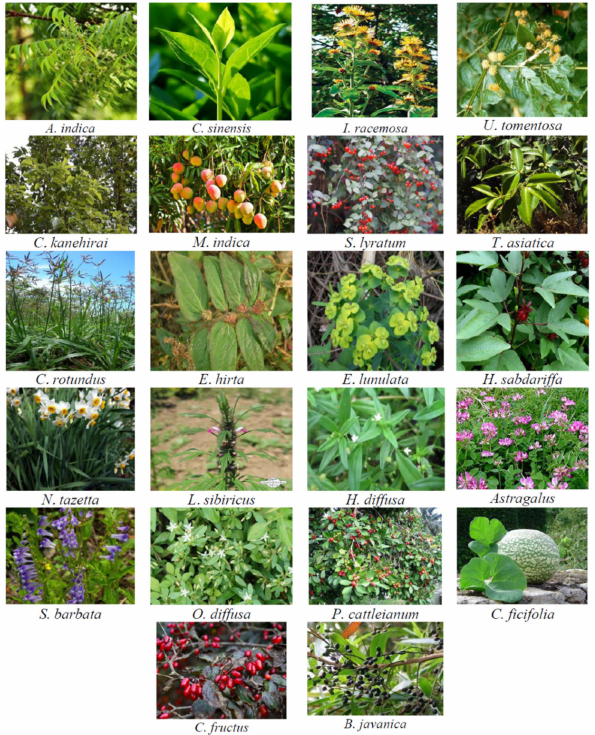
Figure 3. The picture shows representative plants with known proapoptotic activities. Three cancer cell lines (DU-145, PC-3, A-549 cells) were exposed to various concen- trations of nimbolide, which is a triterpene found in neem tree. The data showed that nimbolide significantly activates caspase-3, -8, and -9 compared to untreated control cells. This indicated that nimbolide potently triggers both extrinsic and intrinsic apoptosis